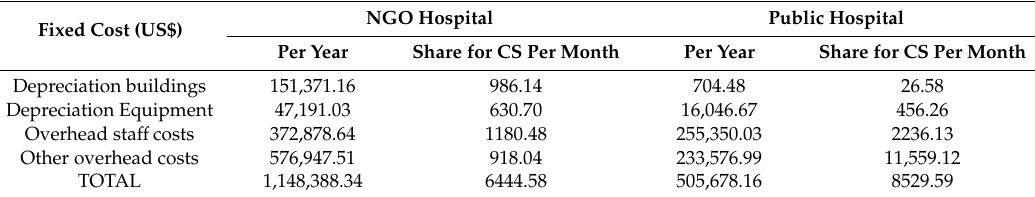
Table 7. Fixed Cost (US$).